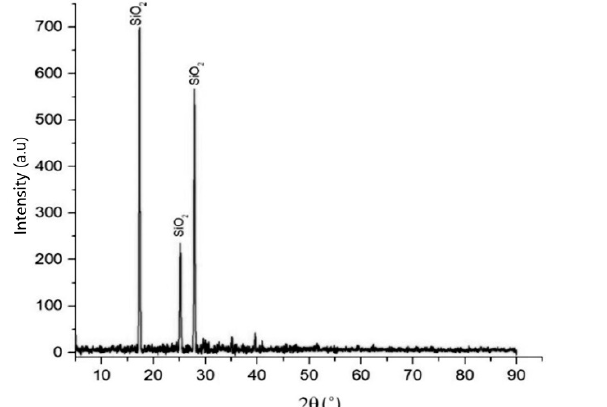
Figure 8. XRD pattern of purified silica after cleaning with deionized water at 60 °C, 300 rpm, s/L ratio 1:4, for 3 h.